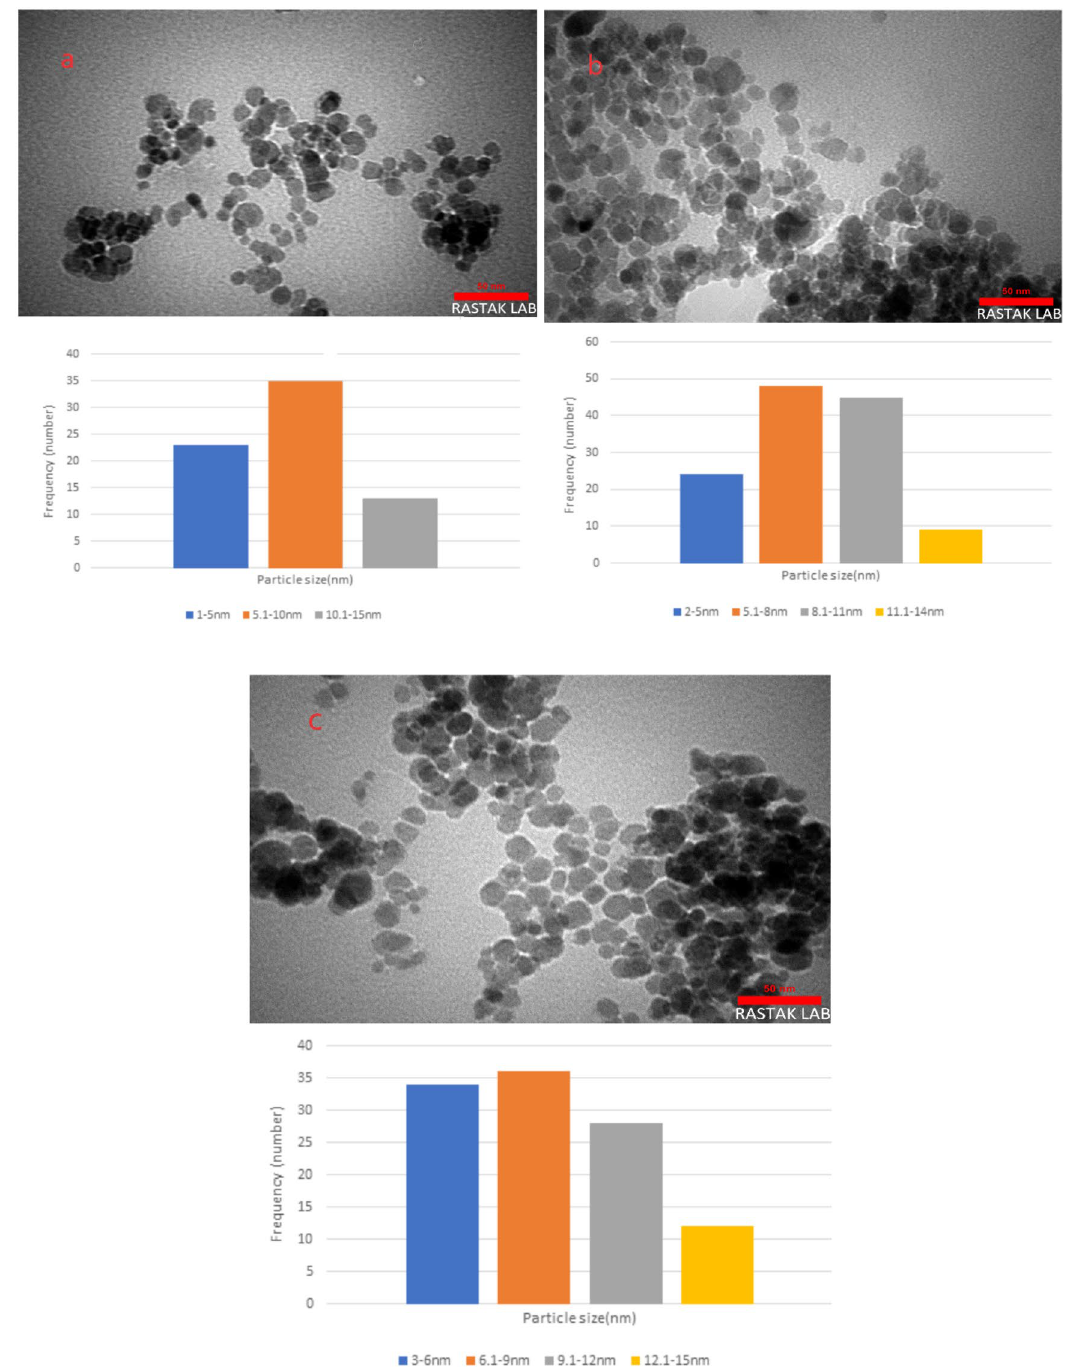
Figure 3. TEM images of Fe 3 O 4 ( a ), Fe 3 O 4 -CPTMS ( b ) and Fe 3 O 4 -PTMS-NAS@Cu MNPs ( c